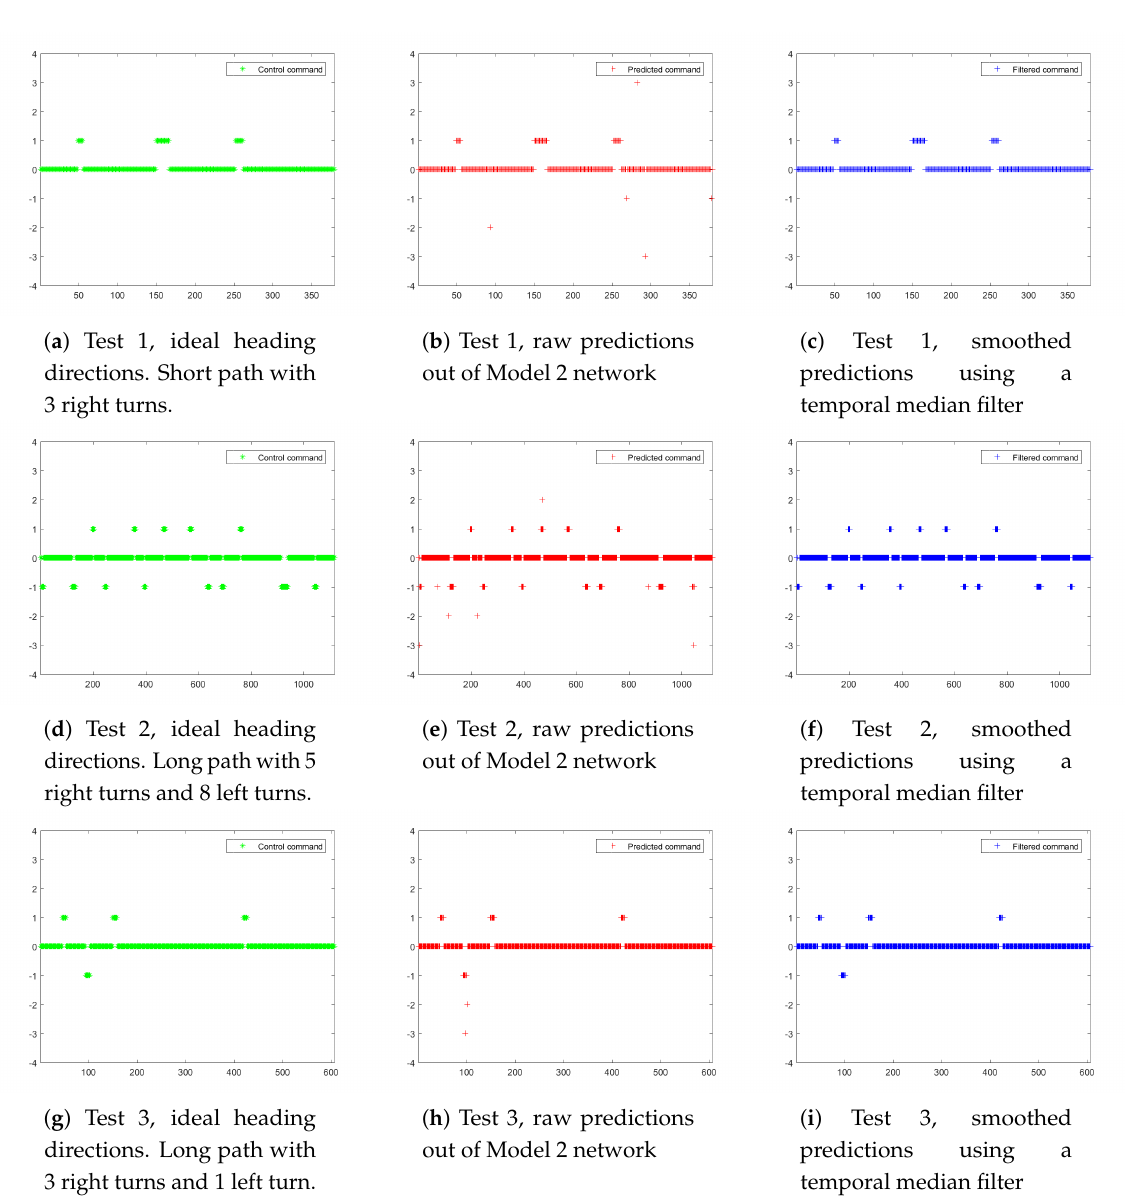
Figure 11. Robot navigation heading directions in 3 separate tests. X-axis: frame index; Y-axis: heading direction choices (0, ± 1, ± 2, ± 3, positive values for right turns and negative values for left turns). ( a , d , b ) are manually labeled ideal heading directions; ( b , e , h ) are corresponding raw predictions from the proposed “Model 2” network; ( c , f , i ) are smoothed predictions using a temporal median filter of size